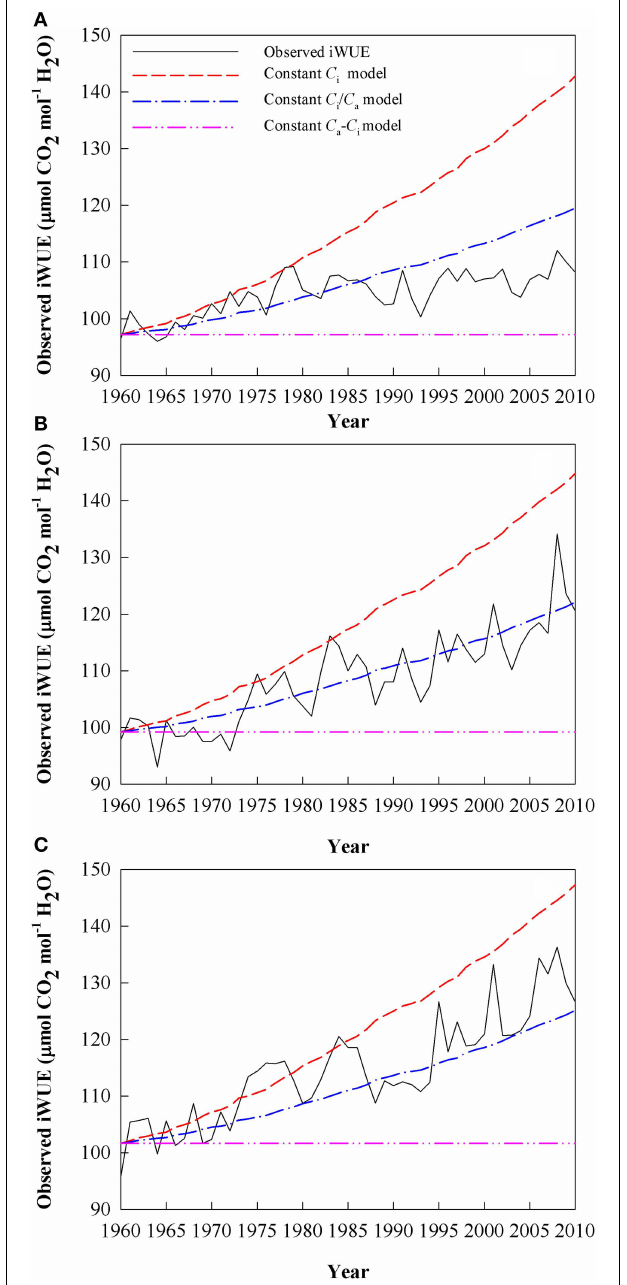
FIGURE 6 | The observed and theoretical changes in intrinsic water-use efficiency (iWUE) calculated using Equation (3). The three scenarios for the theoretical regulation of leaf gas exchange in response to an increasing atmospheric CO 2 mole fraction ( C a ) are: (i) a constant intercellular CO 2 mole fraction ( C i ); (ii) a constant C i / C a ratio, and (iii) a constant C a - C i value. Values are for (A) Site A1 (2700m a.s.l.), (B) Site A2 (2400m a.s.l.), and (C) Site A3 (2200m a.s.l.).